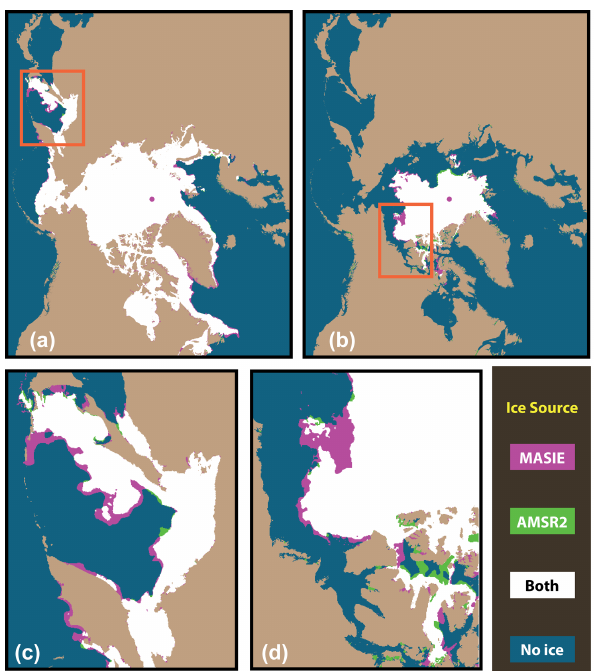
Figure 4. AMSR2 and IMS/MASIE ice extent differences during (a) 15 March 2014 – winter and (b) 15 September 2014 – summer. Magenta: IMS/MASIE shows ice where AMSR2 does not show ice greater than 15%. Green: AMSR2 shows ice where IMS/MASIE does not. White: both indicate ice. Blue: both indicate no ice. A closer view of the Sea of Okhotsk region in winter (c) illustrates where the passive microwave data are failing to detect thin ice around the Kamchatka Peninsula and near the ice edge in the Sea of Okhotsk. The much smaller areas where AMSR2 detects ice and IMS/MAISE does not (shown in green), may be due to a mismatch in data acquisition time. The Beaufort Sea on this day in summer (d) has a large expanse of ice not detected by the AMSR2